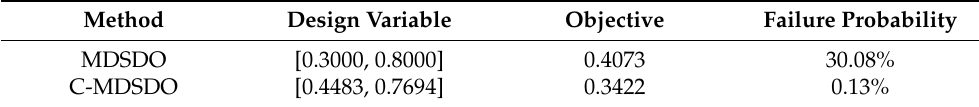
Figure 15. The comparison of control strategies for MDSDO and C-MDSDO. 520 Table 6. The optimization result comparison for MDSDO and